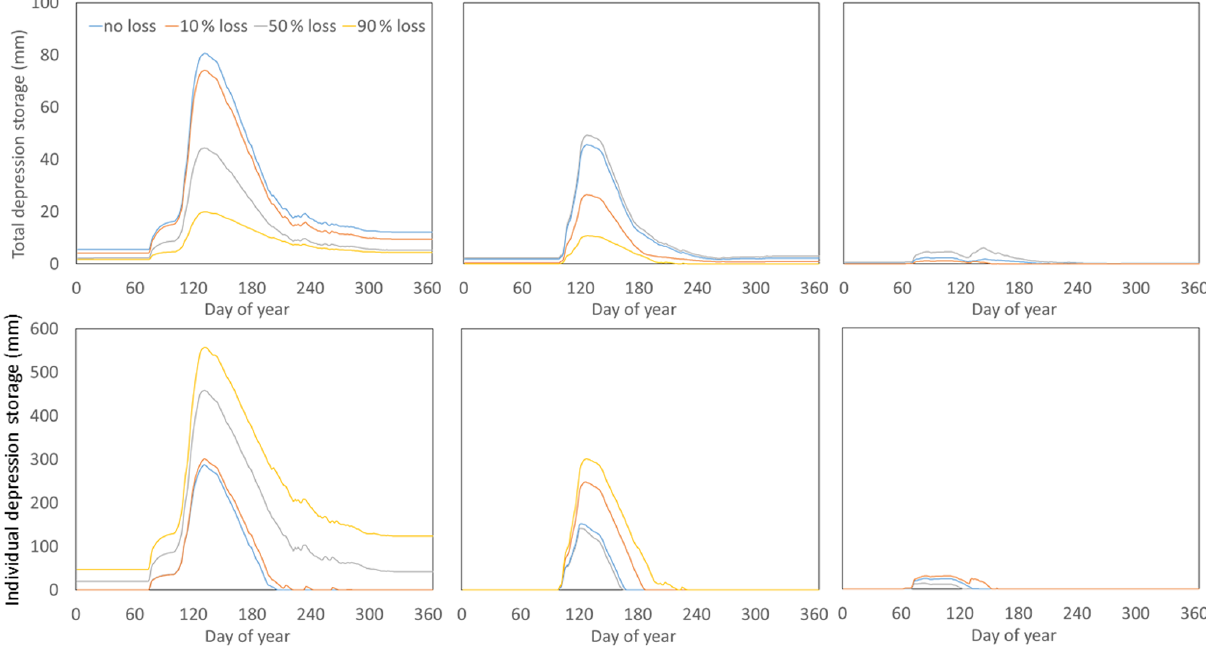
Figure 8. Total depression storage in millimetres across the entire 100km 2 virtual basin for (a) an extreme wet year (e.g. 1974), (b) the median year (e.g. 1969), and (c) an extreme dry year (e.g. 2000). Similarly, individual depression storage held in one 0.08km 2 wetland during (d) an extreme wet year (e.g. 1974), (e) the median year (e.g. 1969), and (f) an extreme dry year (e.g. 2000) is shown.